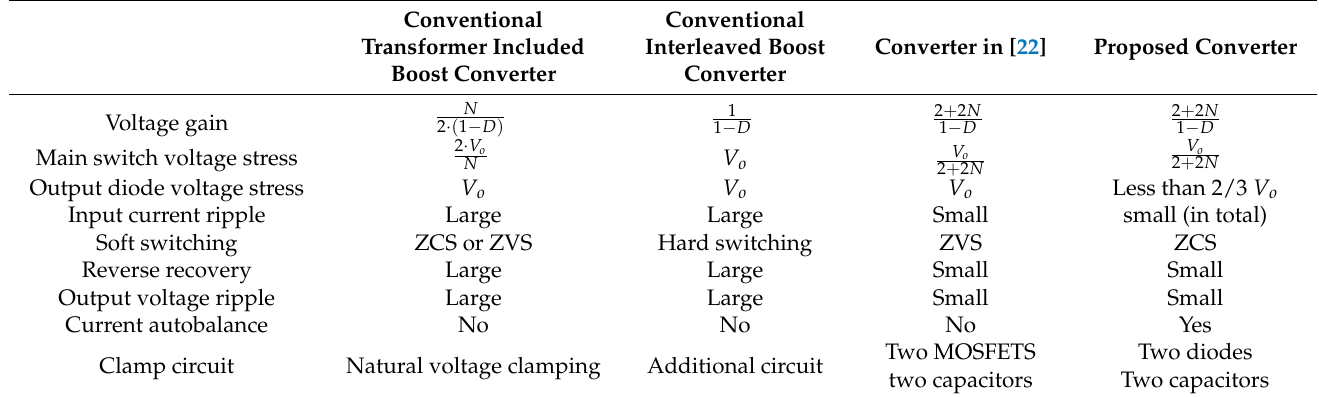
Table 1. Converter performance